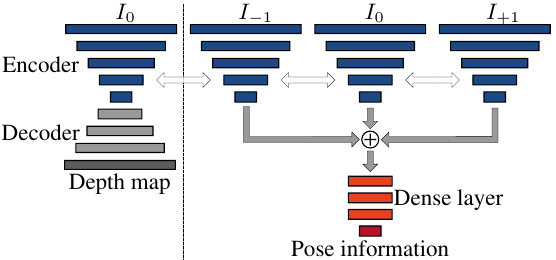
Figure 3. Network architecture with depth estimation (left) and pose estimation (right) networks, sharing the encoder (blue). For pose estimation, the feature maps are concatenated and passed through the dense layers with a final global average